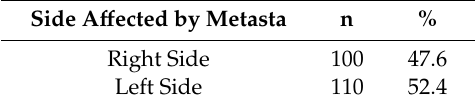
Side A ff ected by Metasta n % Right Side 100 47.6 Left Side 110 52.4